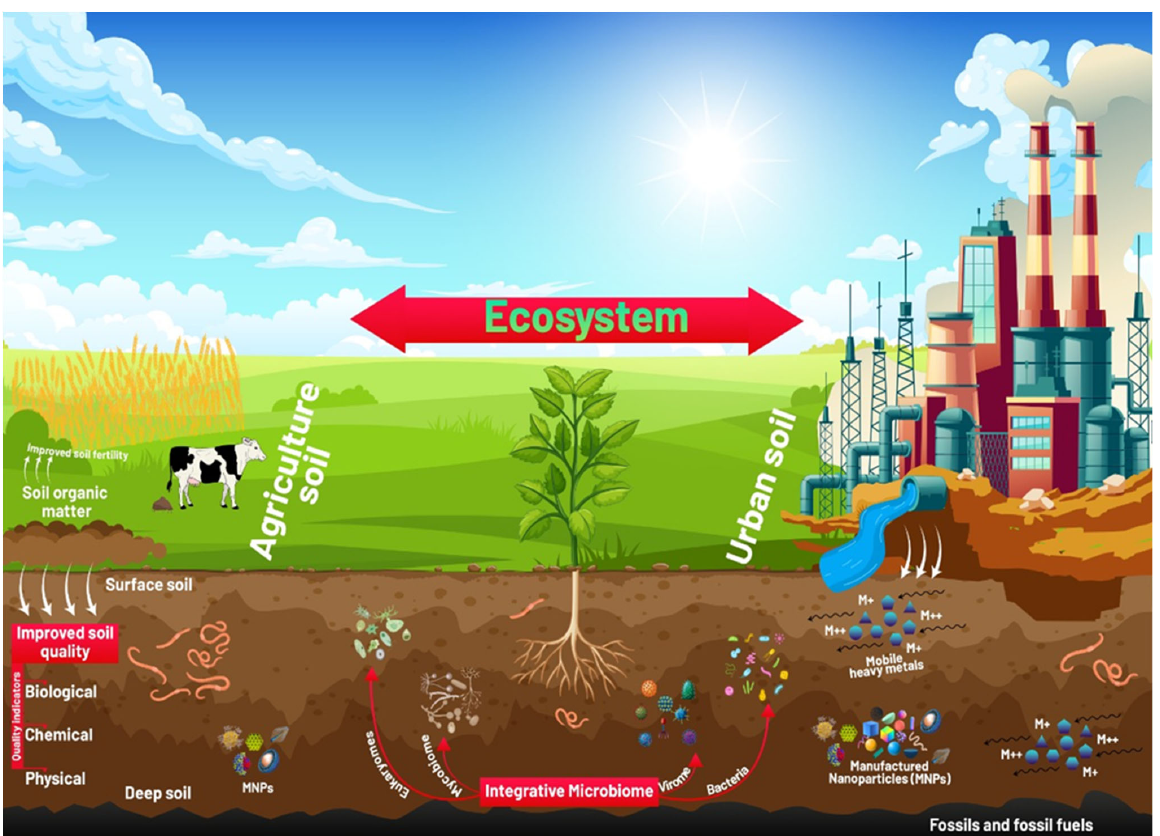
Figure 5. How manufactured nano ‐ objects are deteriorating the soil